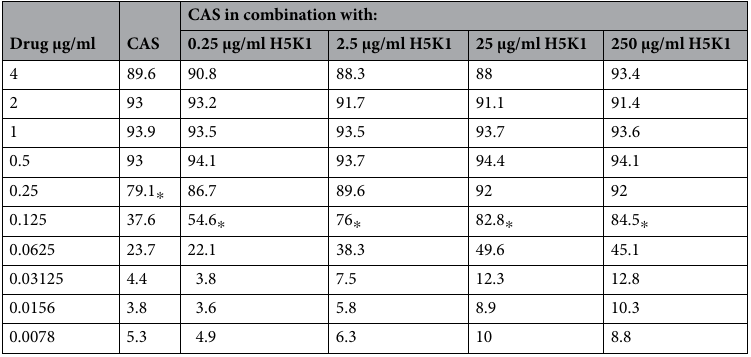
AMB in combination with: